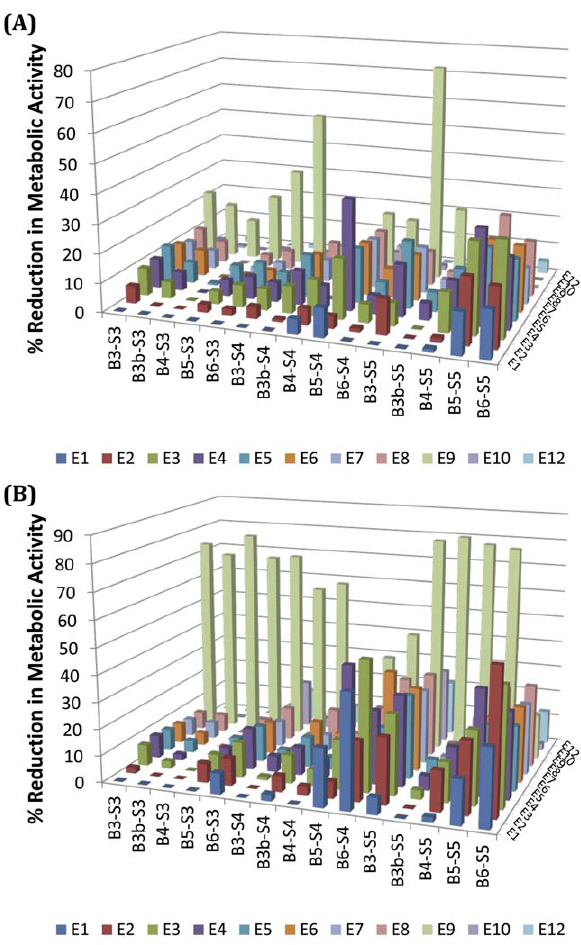
Figure 4. Reduction in metabolic activity following PBAE nanoparticle administration. Formulations plotted at 0% reduction of metabolic activity here had equivalent or slightly higher metabolic activity than untreated controls. (A) Reduction in metabolic activity post transfection with polymer library formulated at 30 w/w ratio (n=4). (B) Reduction in metabolic activity post transfection with polymer library formulated at 60 w/w ratio (n=4). alcohol groups as well as 5 carbons in its hydrocarbon portion of its base chain between acrylate groups. In a second step, the acrylate ends of the polymer intermediates are modified by a second amine, resulting in the final end-modified polymers ( Figure 1B ). The base polymers were end-capped by end-capping (‘‘E’’) amines (at 10-fold molar excess of amine to diacrylate termini) at room temperature in DMSO at 100 mg/ml for 1 hr ( Figure 1B ). Specifically, 80 mg of base polymer was dissolved in 400 m l of DMSO, and combined with 320 m l of a 0.5 M solution in DMSO of the end-capping amine, and placed on a multitube vortexer (VWR) and vortexed for 1 hr at 1000 RPM. The library of monomers used here is shown ( Figure 1C ). For the end capping amines, the number is simply sequential; B5-S5-E7 is an end-modified polymer with 5 carbons in the base, 5 carbons on the side chain, and which was end-modified with the E7 end-capping amine. For this study we synthesized a combinatorial library of PBAEs using 5 diacrylates, 3 amino-alcohol side chains, and 11 end-modifying amines to form 165 end-modified polymers with only small, single carbon changes to the backbone and side chains,